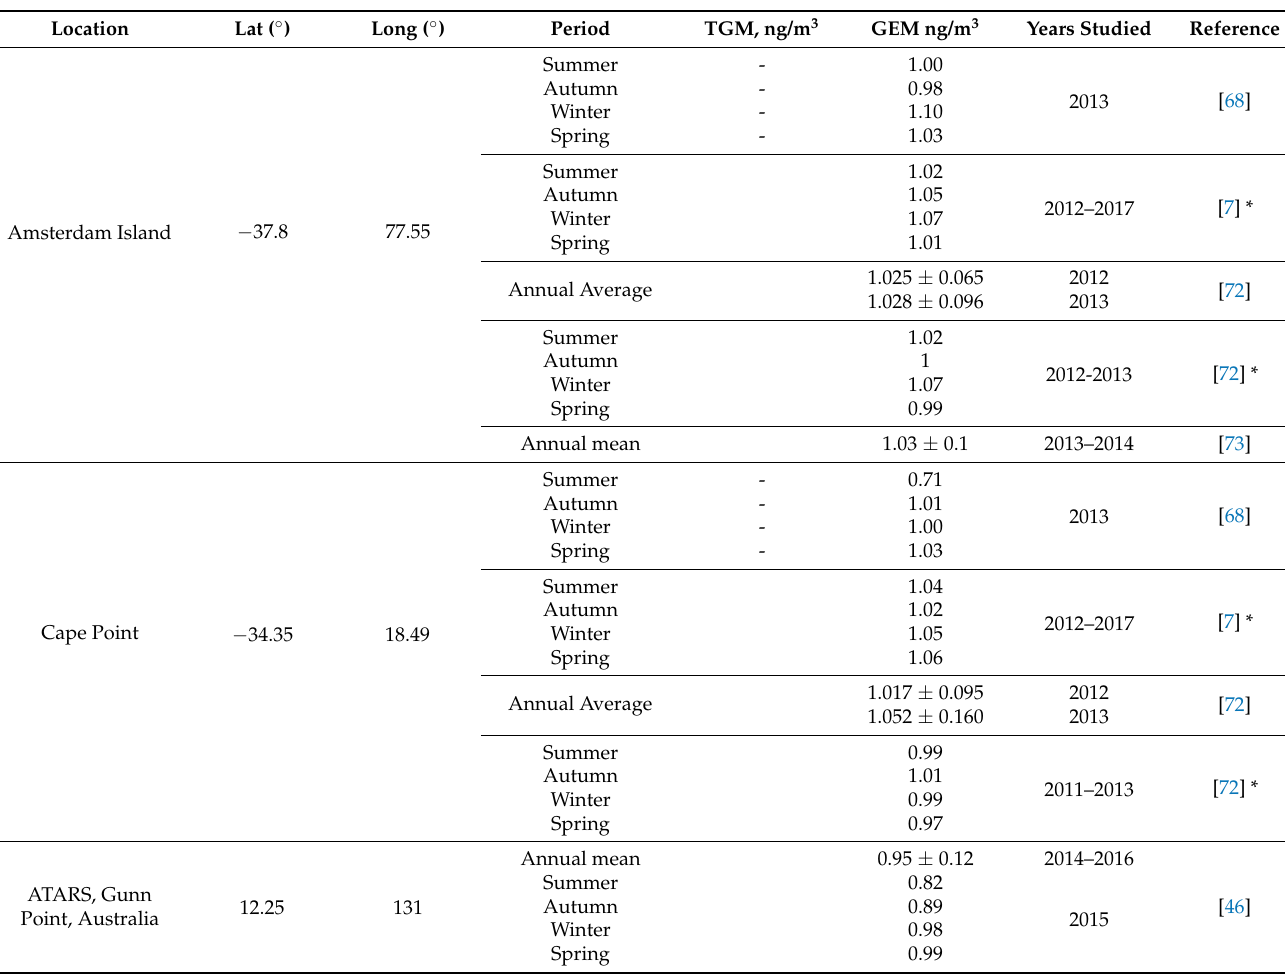
Table 3. Different observed values for TGM and GEM in the SH. To achieve values for each season, the data for * studies are interpreted from graphs and tables. The seasons are summer between January and March, Autumn between April and June, Winter between July and September, and Spring between October and December. The instrument used to measure atmospheric mercury in the monitoring stations was the Tekran continuous mercury vapour analyser, model